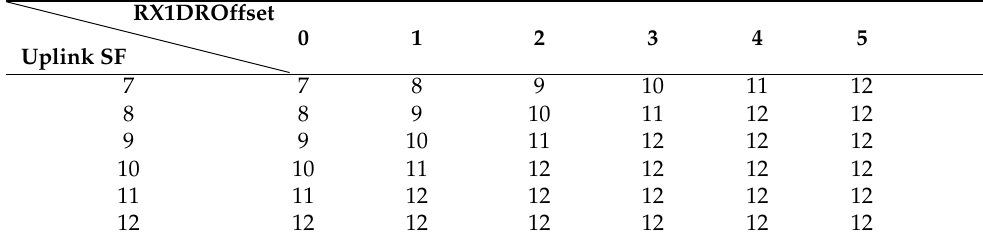
Table 4. RX1DROffset